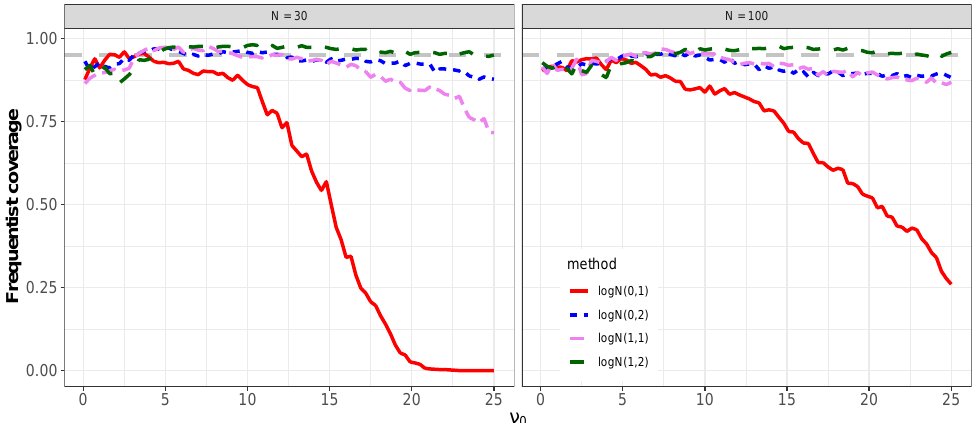
Figure 4. Frequentist coverage of 95% credible intervals for the degrees of freedom based on the four log-normal priors π ( ν ) = log N ( ν ; µ , σ 2 ) with ( µ , σ 2 ) ∈ { ( 0,1 ) , ( 0,2 ) , ( 1,1 ) , ( 1,2 ) } for sample sizes N = 30 and N = 100. The horizontal dashed line represents 0.95 target